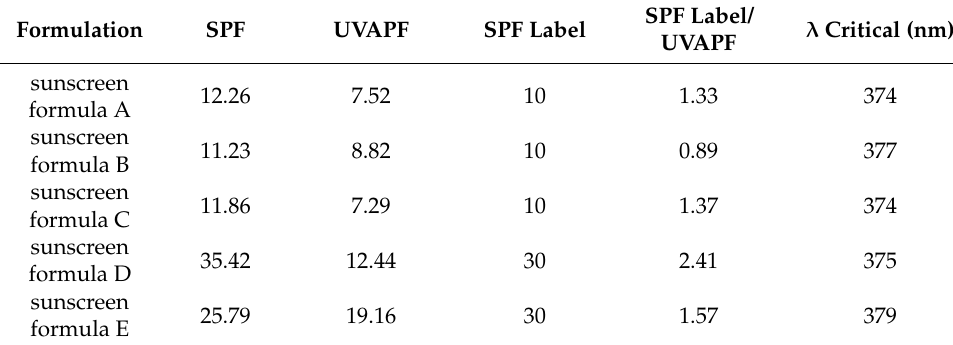
Table 5. SPF analysis for each